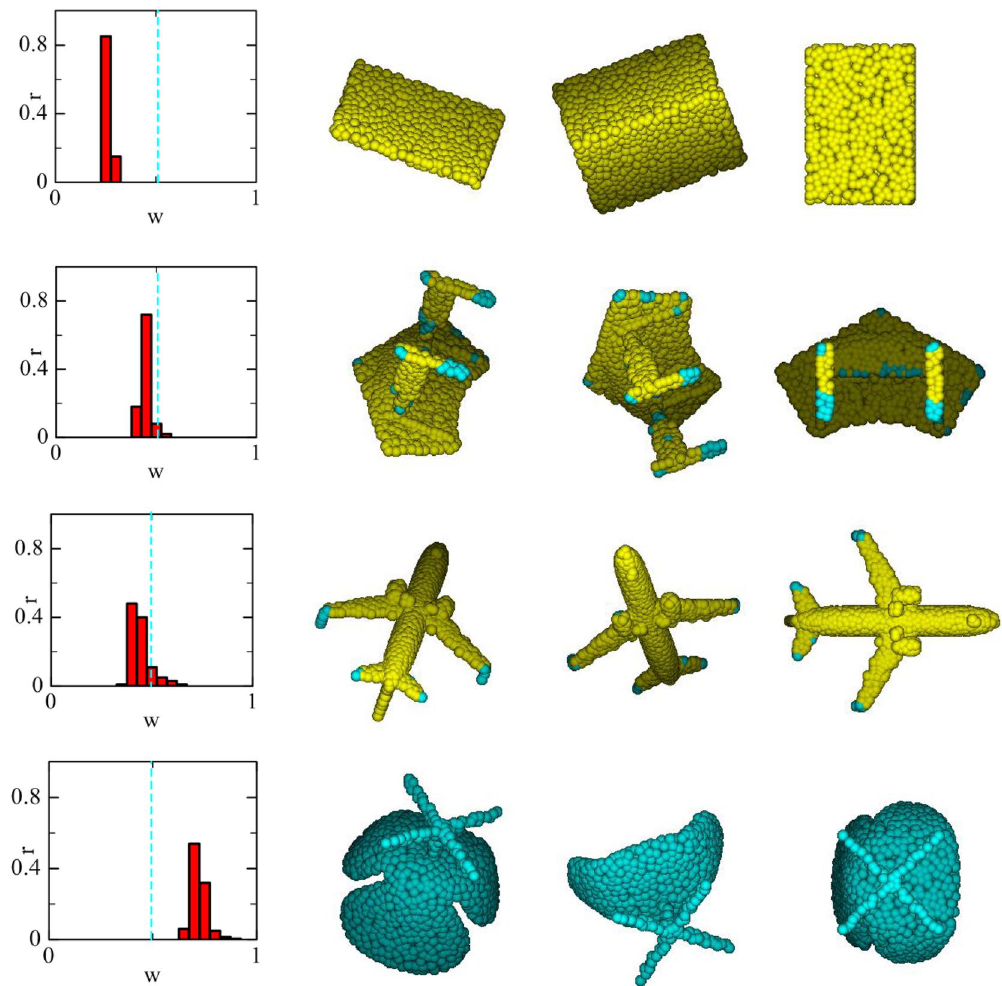
Figure 7. Left: the histogram represents the distribution of search weight in feature space( w f ). Right: In the point cloud, the points in yellow are more likely to search the neighborhood in 3D space ( w xyz > w f ), while the points in cyan are more likely to search in feature space.